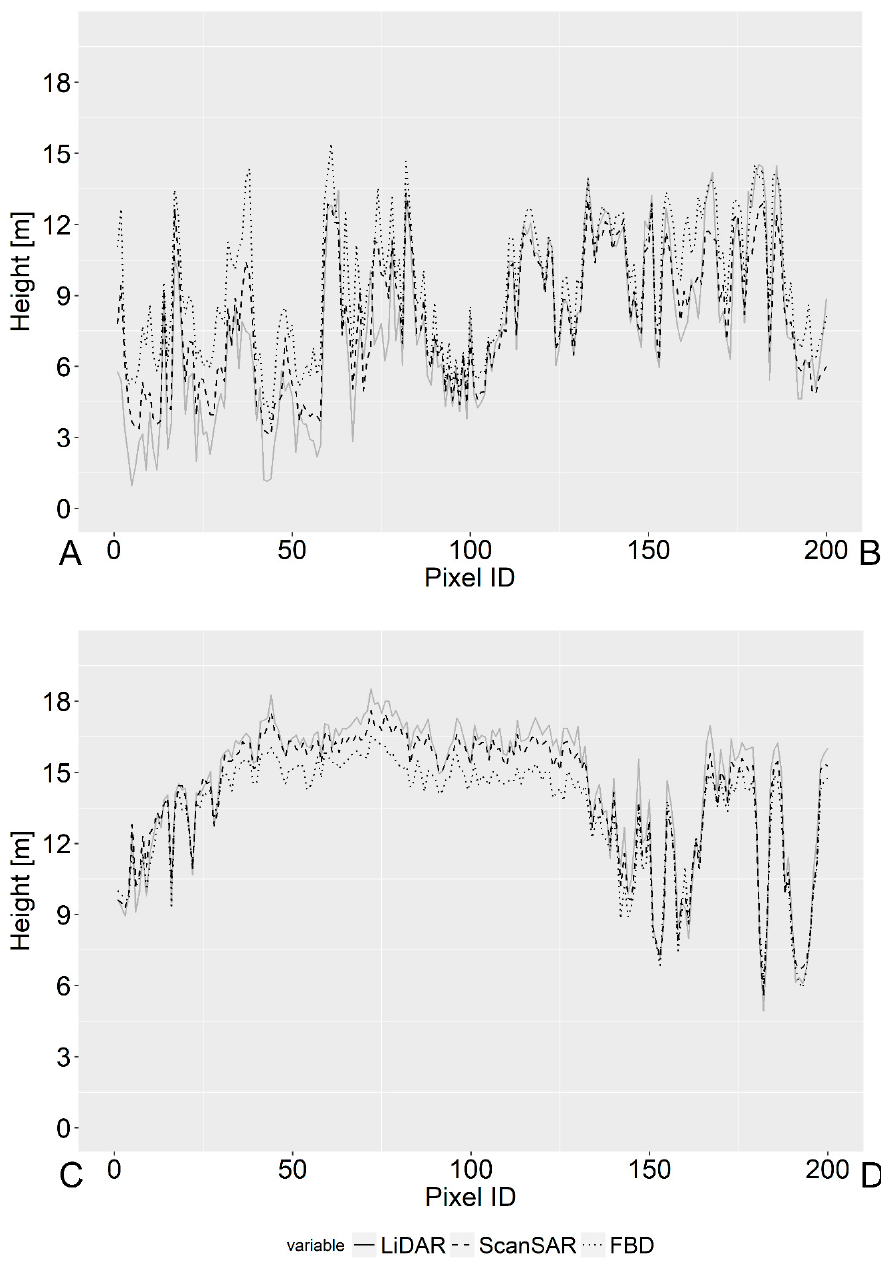
Figure 8. Transects of the vegetation height of the three products over areas with small ( upper profile) and tall trees ( bottom profile). The upper image shows vegetation height for the transect A-B in the northern part of the peninsula (Figure 7), while the bottom image shows vegetation height for the transect C-D in the central part of the peninsula (Figure 7). The FBD-based map overestimated height in areas with small vegetation and underestimated in areas with tall vegetation more noticeably compared to the ScanSAR-based map. For visualisation reasons, every 5 pixels from north to south was averaged.